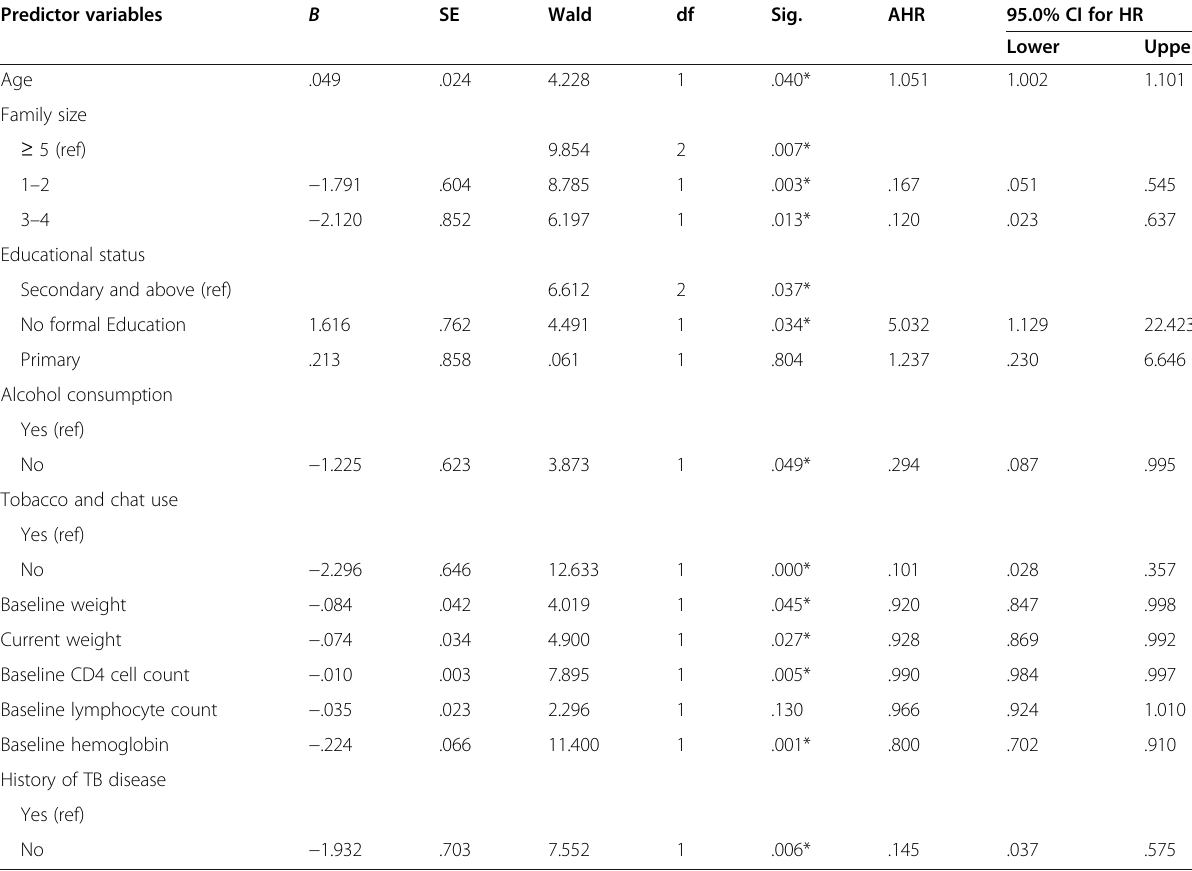
Table 5 The hazard estimates of covariates associated with the survival time of HIV/AIDS patients under ART follow-up (University of Gondar teaching hospital, 2009 – 2015) Predictor